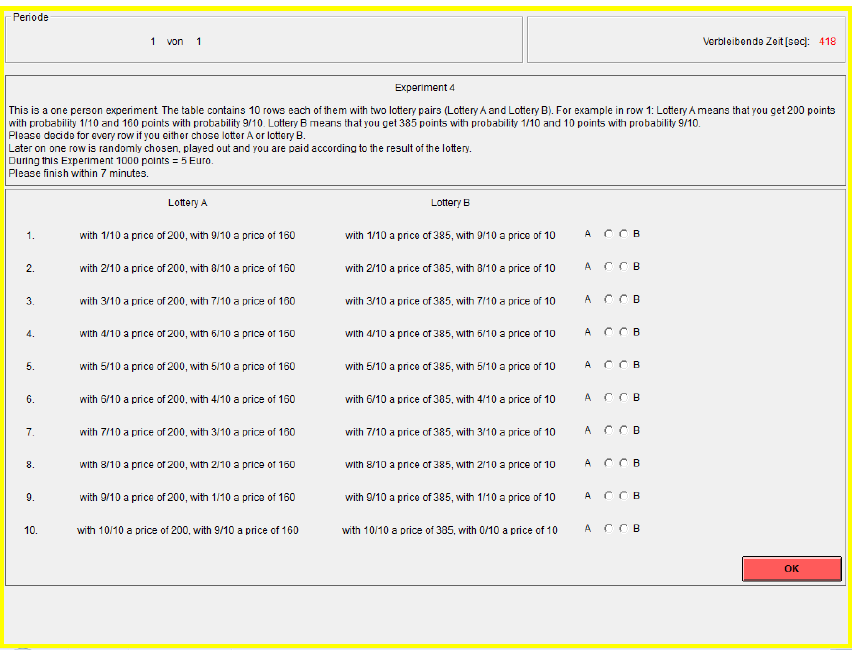
Figure A3. Z-Tree Screenshot of Elicitation of Risk Preferences. Notes: Players have to decide upon one of two lotteries in every row. The procedure is as proposed by Holt and Laury (2002).